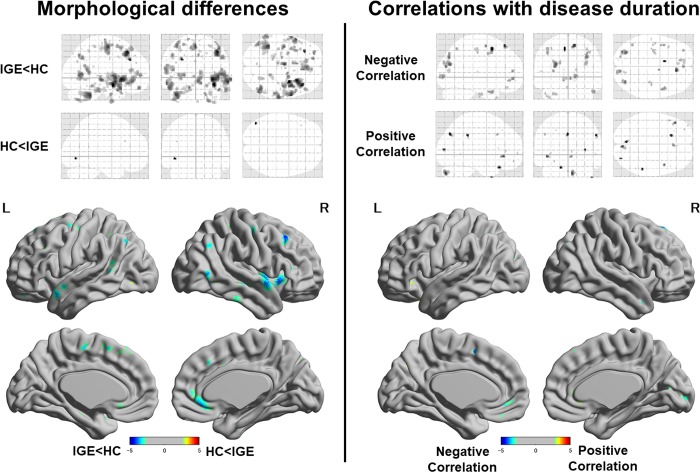
Glass brains (upper) and T-value maps (lower) regarding the morphological differences between groups (left) and correlations with disease duration in the IGE group (right). The reported regions are thresholded at the level of an uncorrected p < 0.005 (T > 2.65 in comparison, T > 2.76 in correlation).